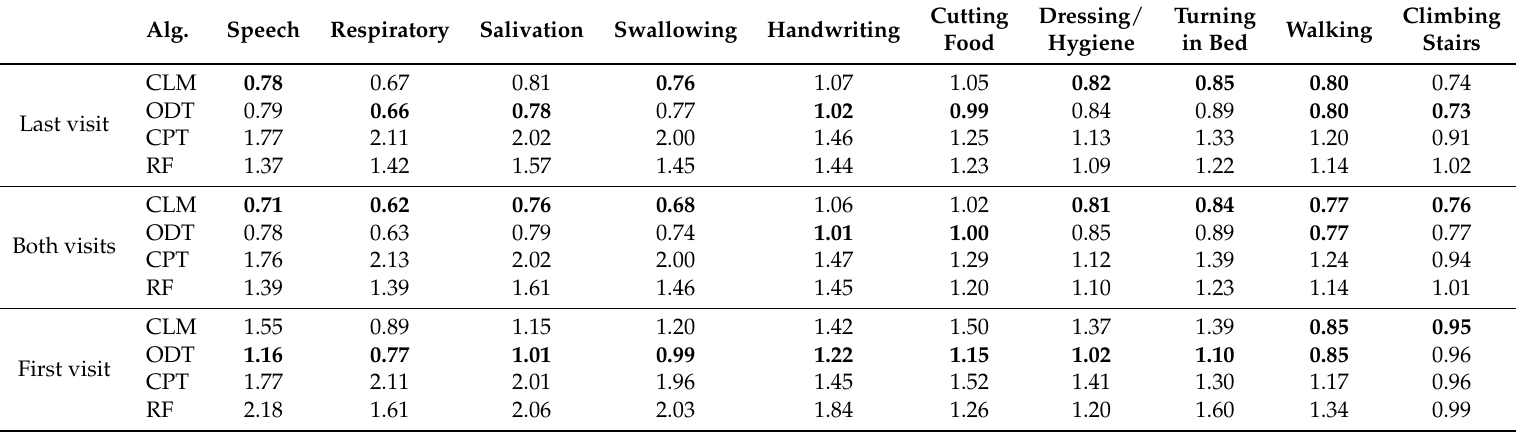
Table 4. MAE averaged over CV-10 for three settings, four prediction models, and ten ALS functions ( bold is best over algorithms). Alg.